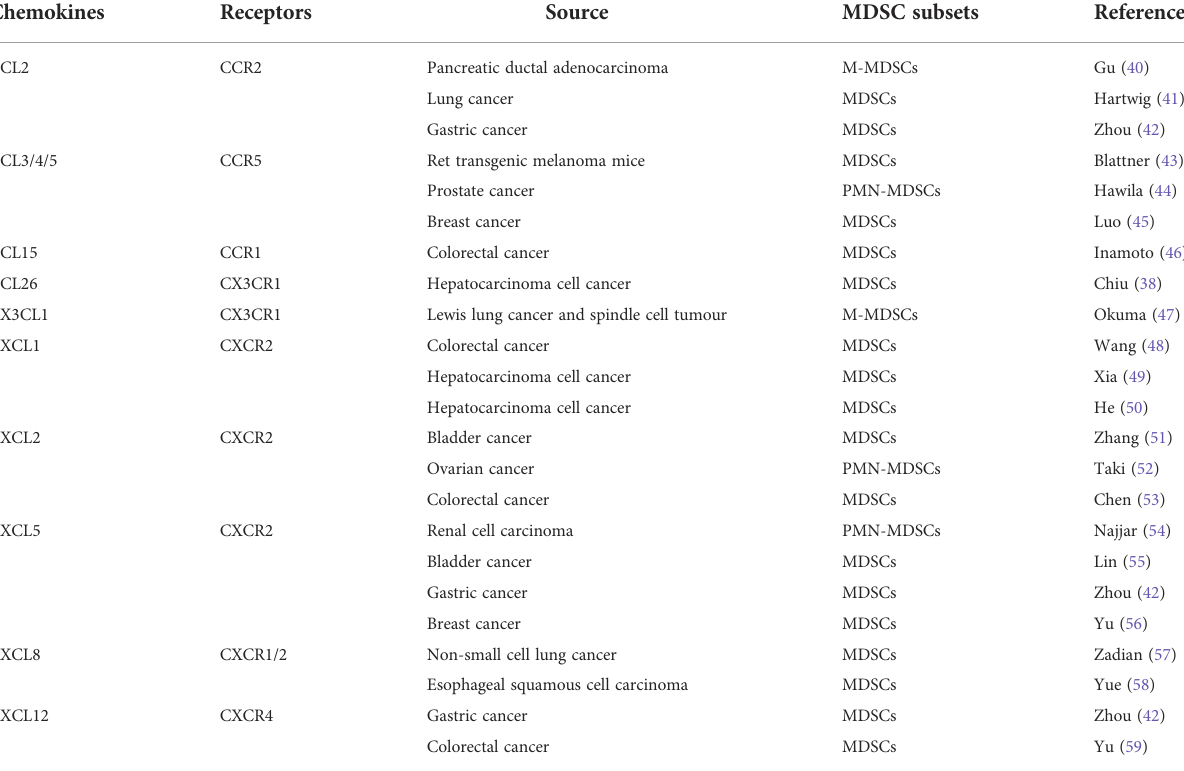
TABLE 2 Major chemokines involved in regulating MDSCs recruitment.